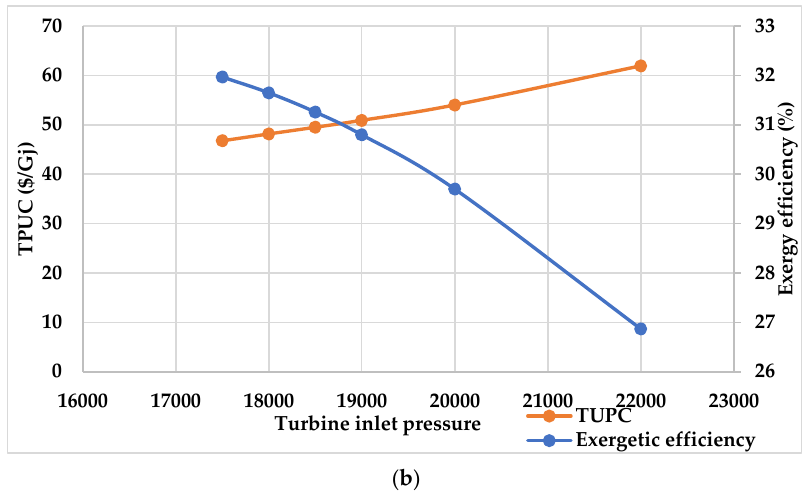
Figure 11. ( a ) Effect of turbine inlet pressure on energy efficiency, cooling, and power generation. ( b ) Effect of turbine inlet pressure on exergy efficiency and TPUC.